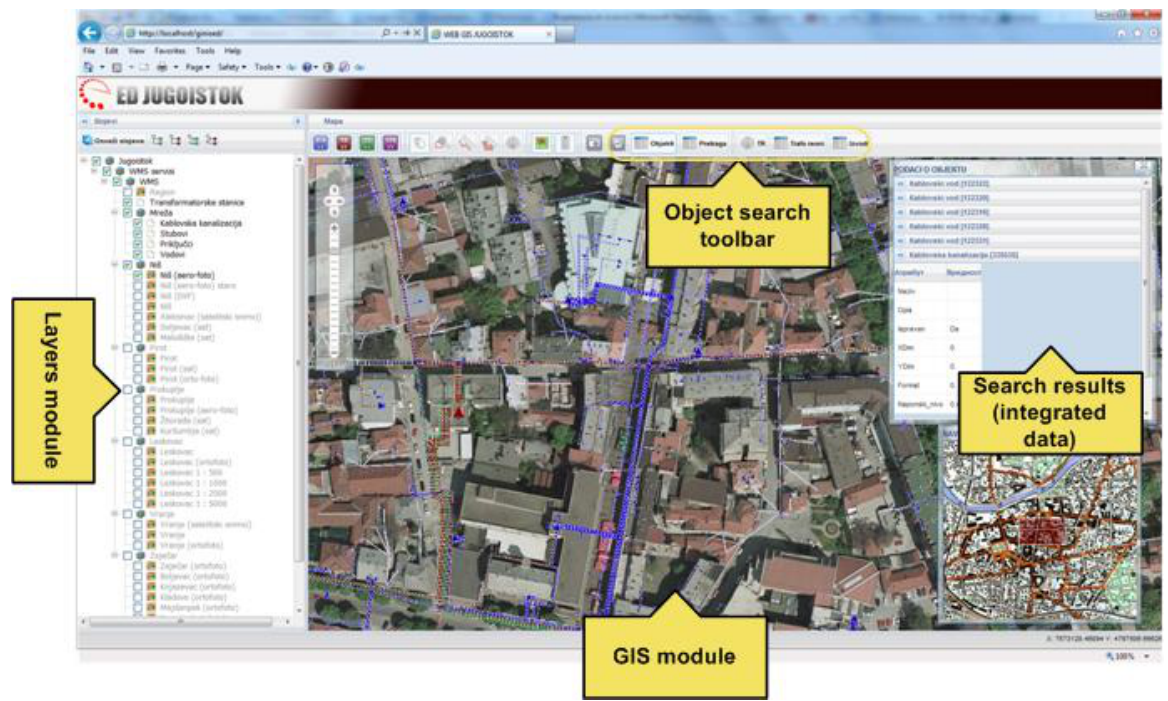
Figure 3. Web GIS application—client side modules’